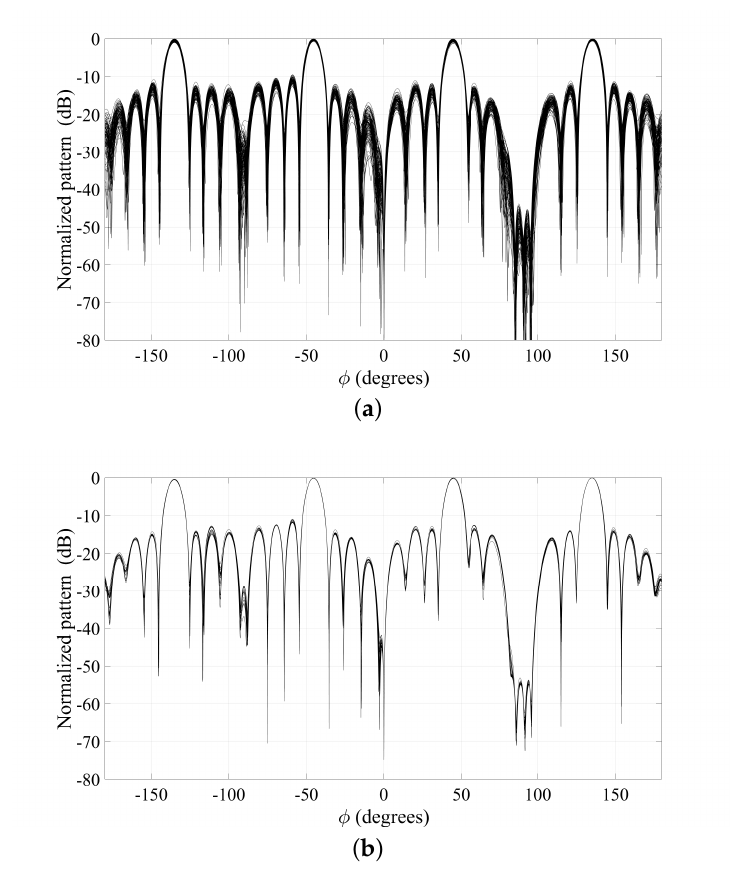
Figure 10. Fourth example: overlapping of one hundred 2D pattern cuts at θ = 30 ◦ obtained by randomly selected starting points for ( a ) I max = 100 and ( b ) I max =